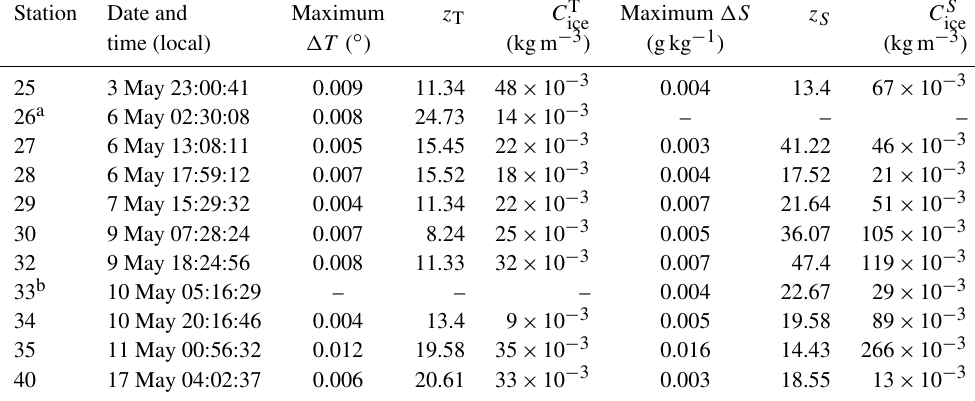
Table 1. CTD stations with temperature and salinity anomalies (see Figs. 4–5), showing maximum values of the temperature anomaly, depth range of the temperature anomaly, concentration of ice derived from the temperature anomaly (Sect. 4.1), and the maximum value of the salinity anomaly, depth range of salinity anomaly, and concentration of ice derived from the salinity anomaly (Sect. 4.2). Station Date and Maximum z T C T Maximum ice